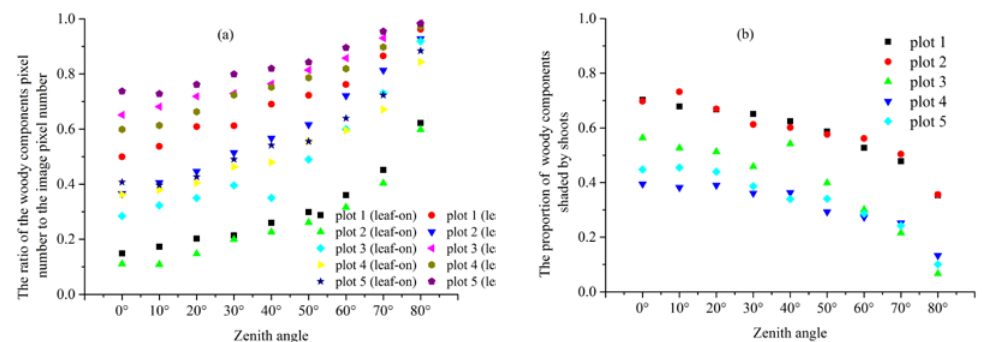
Figure 5. The proportion of the woody components pixel number to the classified MCI image pixel number ( a ) and the proportion of the woody components shaded by shoots, which is calculated by using the classified leaf-on and leaf-off periods MCI images ( b ) at zenith angles ranging from 0° to 80° with a 10° interval in the five plots. The proportion of the woody components shaded by shoots at each zenith angle is derived by taking the ratio of the shaded woody components pixels (calculated by subtracting the woody components pixel number of the classified leaf-on period MCI images from the woody components pixel number of the classified leaf-off period MCI images) to the total classified leaf-on period MCI image pixel number.